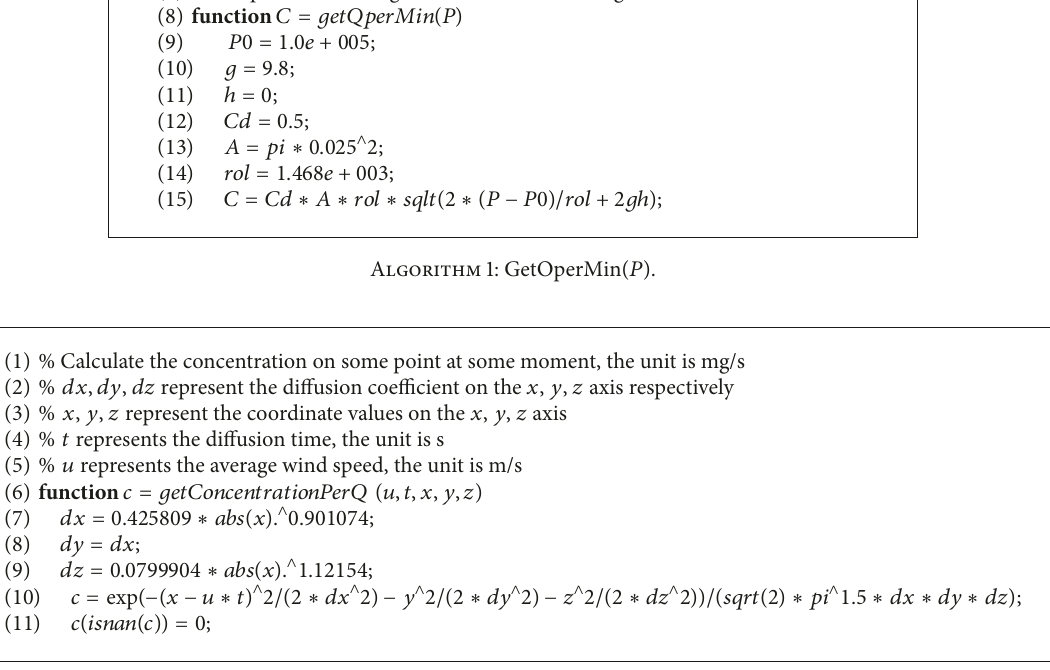
Algorithm 2: GetConcentrationPerQ (𝑢, 𝑡, 𝑥, 𝑦, 𝑧)